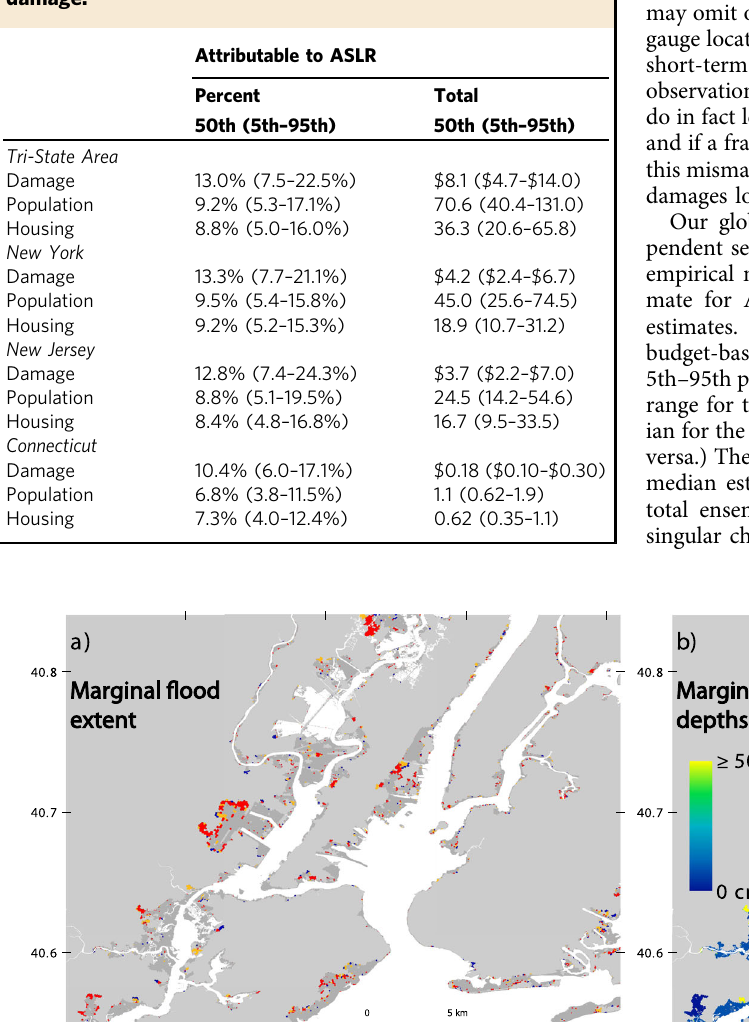
Table 2 Percentage of and total property damage (total in $Billions) and population (thousands) and housing exposure (thousands) attributable to anthropogenic sea level rise (ASLR) as estimated using total ensemble ASLR and full modeling with hydrodynamic simulation, spatial bias correction, and fl ood-depth-based assessment of property damage.